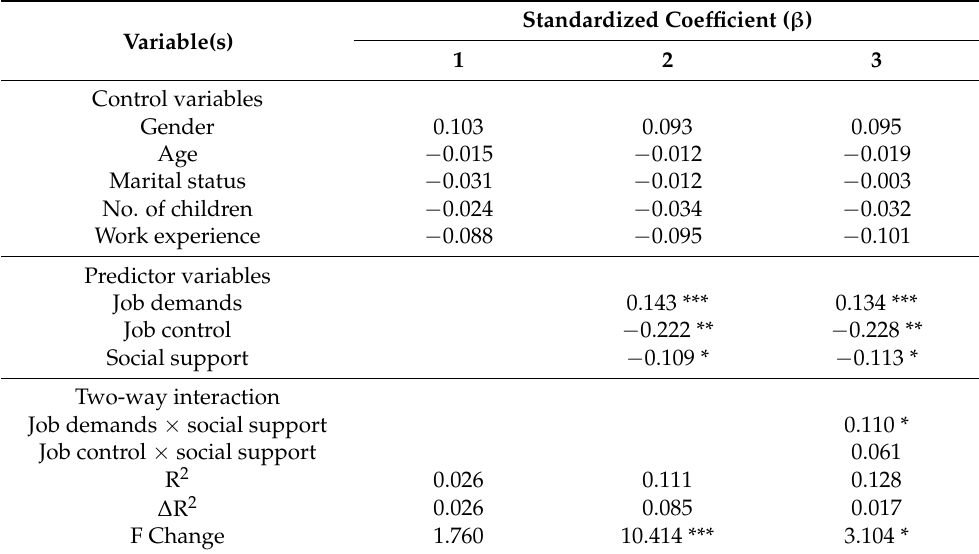
Table 8. The results of hierarchical linear regression model in predicting anxiety.